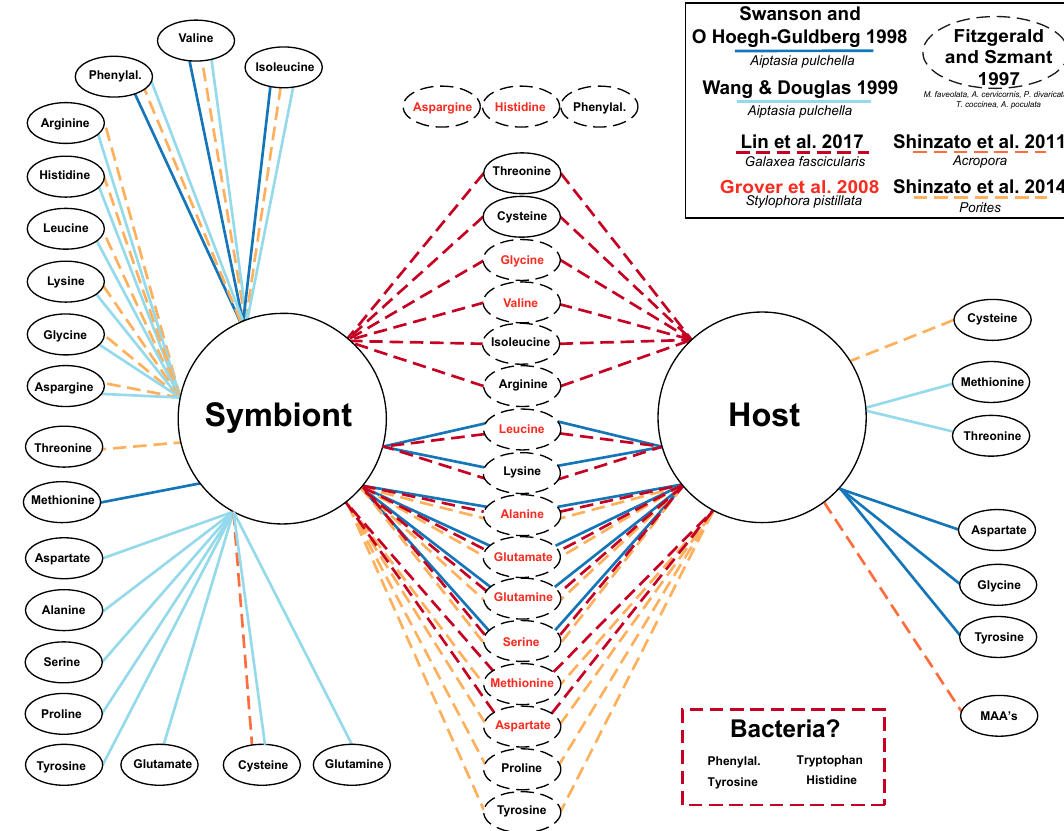
Figure 1. A schematic summarizing of previous research on amino acids (AA) and how they can be synthesized/obtained within the coral holobiont. Dashed lines are studies that used coral, and solid lines are those that used Aiptasia . Ellipses in the middle of the diagram are AA that can be synthesized/obtained by both host and algal symbionts: black hashed ellipses represent the pioneering work of Fitzgerald and Szmant; and red text indicates AA uptake through osmotrophy.